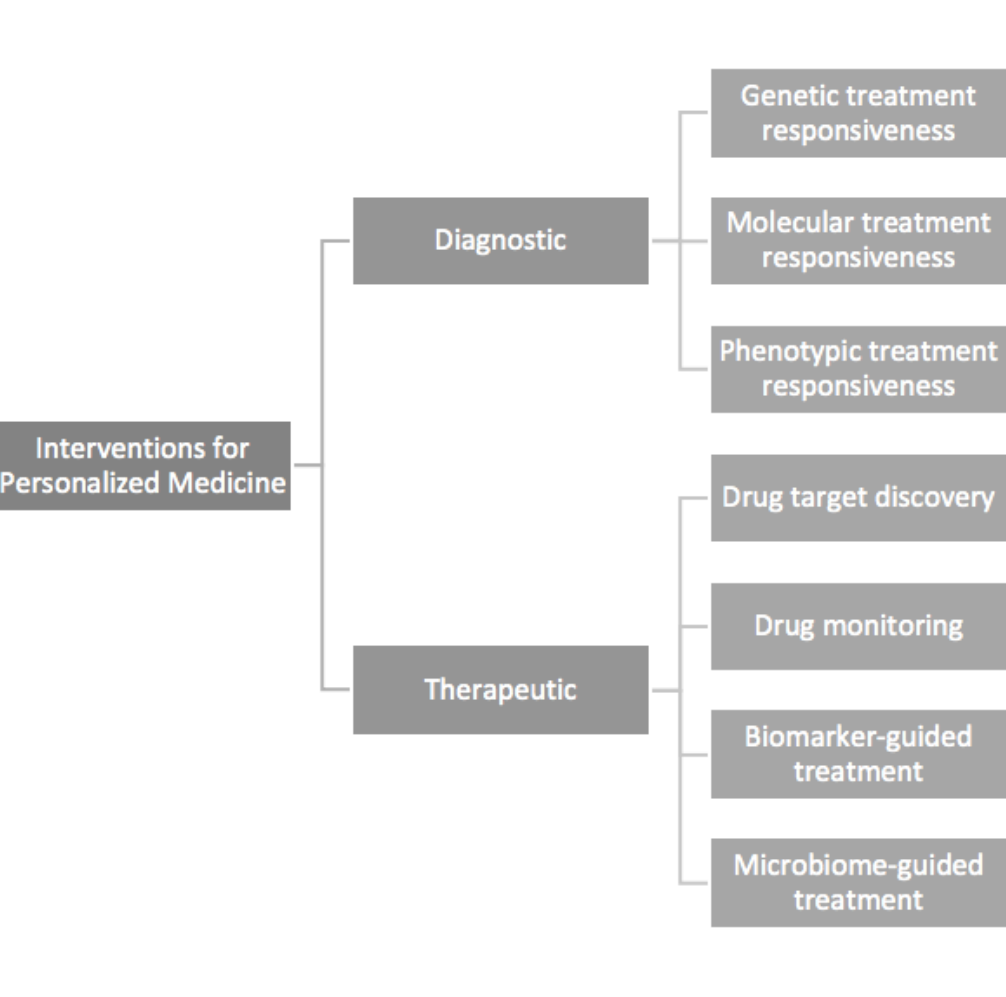
Figure 1. Modalities currently under investigation using translational bioinformatics to promote personalized